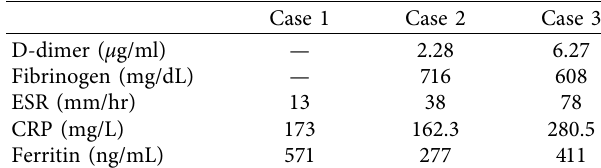
Table 1: Peak markers of inflammation and coagulation.